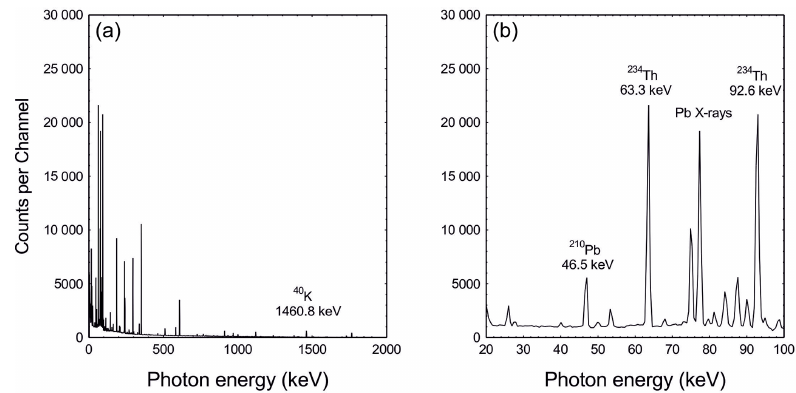
Figure 1. Typical gamma spectra of a natural sample showing the numbers of counts (photon interactions) per channel at energies ranging from (a) 20 to 2000keV and (b) 20 to 100keV. The dispersion is two channels per keV. Peaks in the spectrum identify emissions from specific